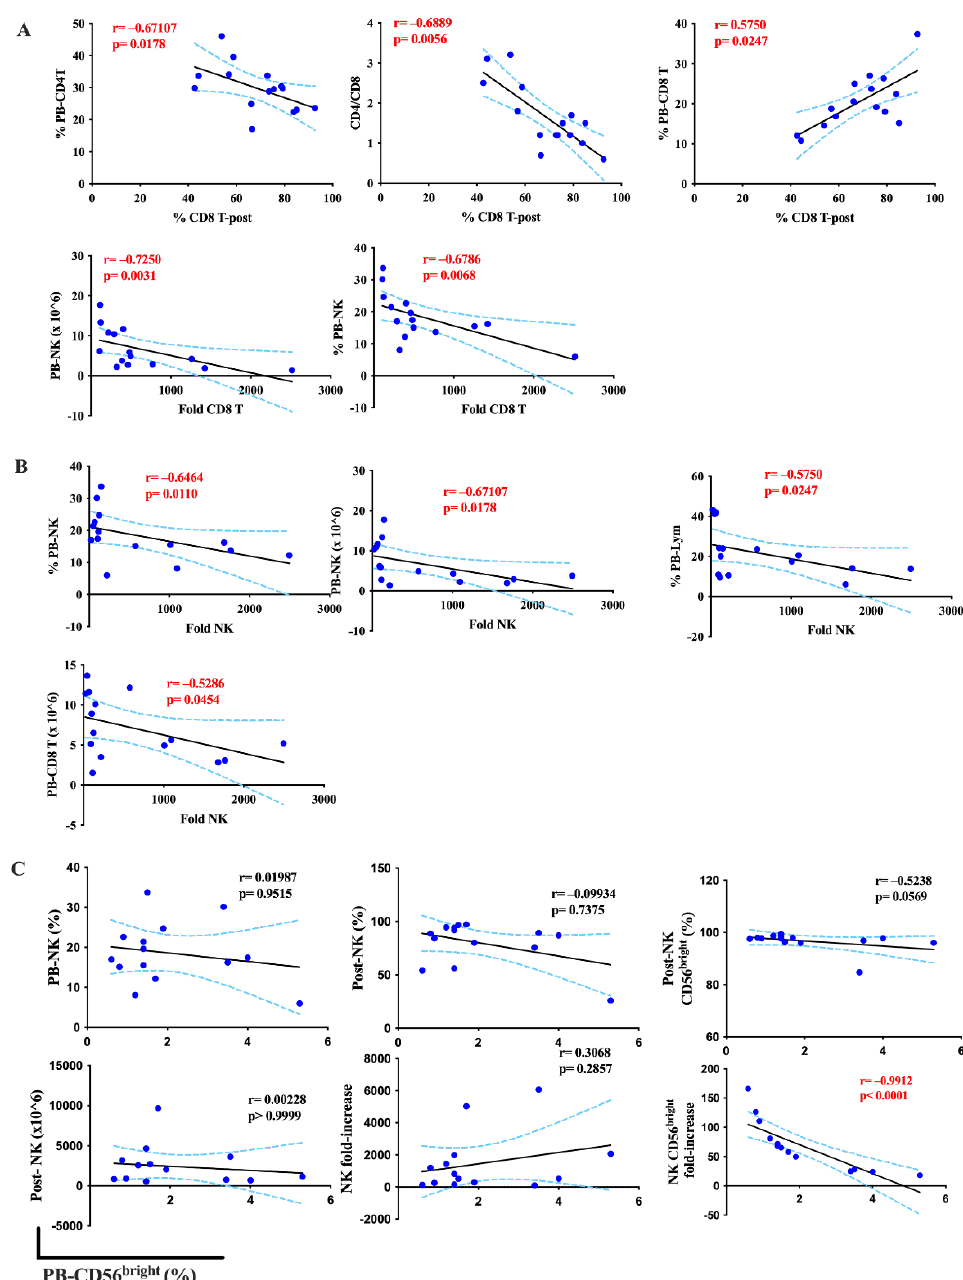
Figure 5. Correlation of peripheral blood indices and the expansion of CD8 + T cells and NK cells in lung cancer patients. ( A ) The relationship of PB indices and the expansion capacity of CD8 + T cells. ( B ) The relationship between PB indices and the expansion capacity of NK cells. ( C ) Relationship of PB- CD56 bright NK (%) with NK cell growth. Spearman’s rank coefficient was used for correlation analysis and non-linear regression was also applied. Median values and interquartile ranges were plotted in graphs. Significance levels were set to p < 0.05, p < 0.01, and p < 0.001. PB: Peripheral blood; Pre-: At seeding; Post-: After